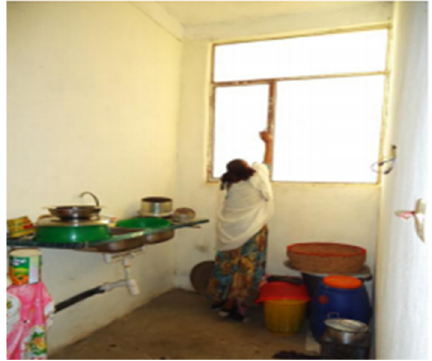
Figure 16. Kitchen with small operable window in a condominium house.